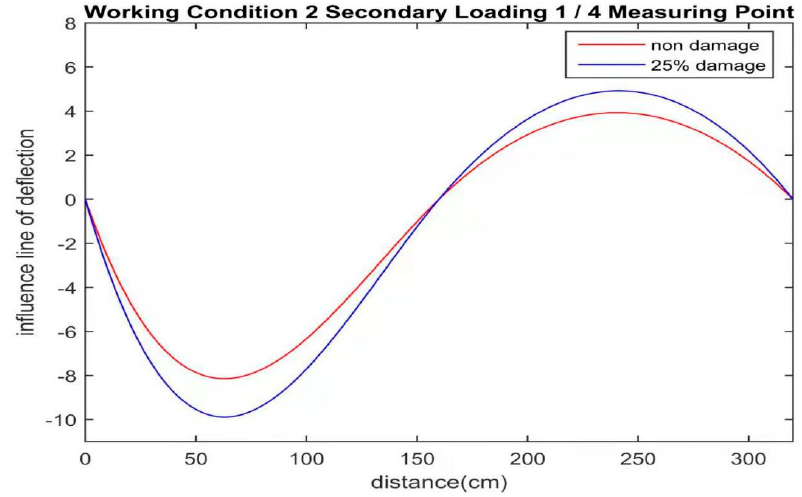
Figure 29. Deflection influence line at 25/100 determining point of the first span in work condition 5.